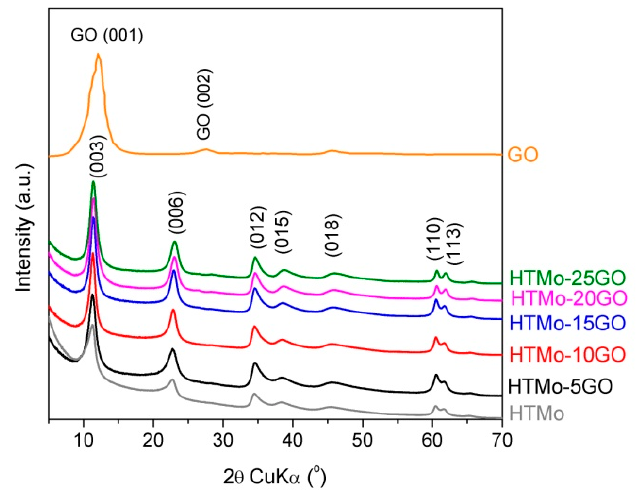
Figure 2. XRD patterns of HTMo-xGO materials compared to HTMo and GO.